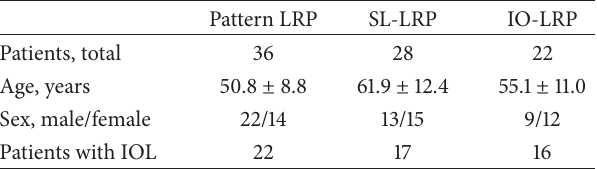
Table 2: Characteristics of the study population.